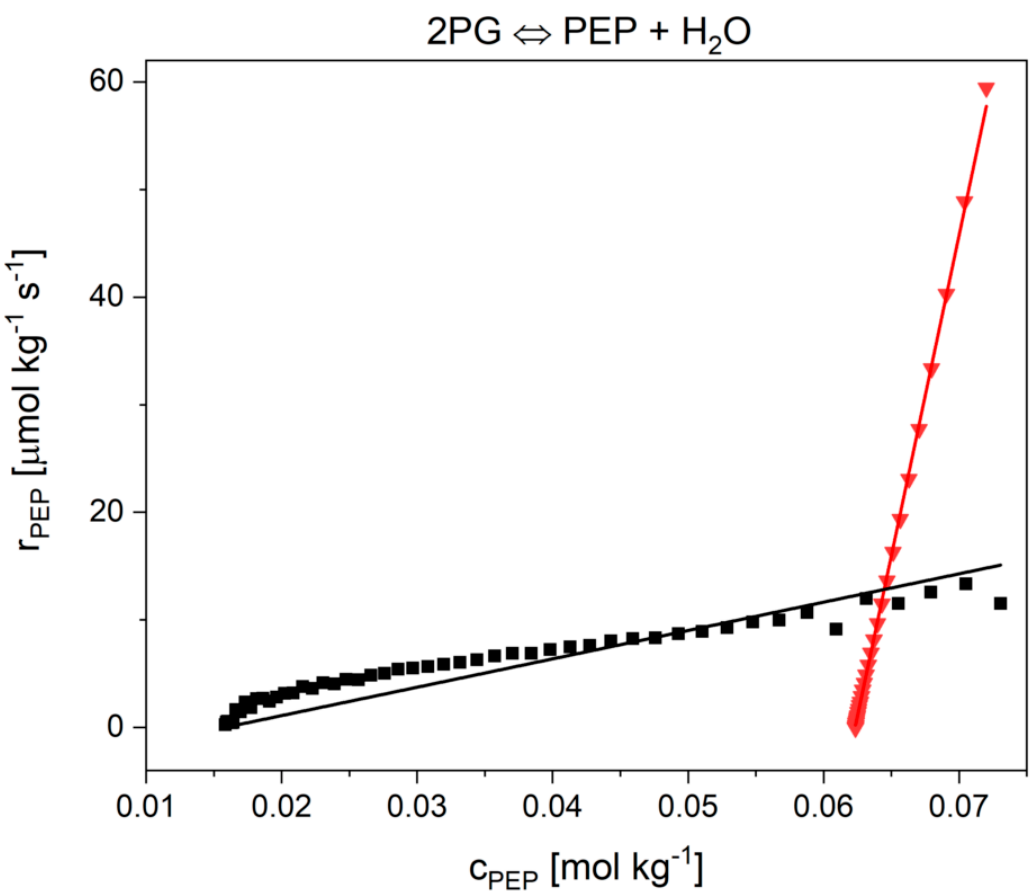
Figure 4. Fitting of the kinetic data (scatter) with the Noor model (solid lines). The adjustable parameters were Λ and K 2PG . Reaction in the presence of high crowding agent concentrations of 250 g kg − 1 PEG 20.000 (black squares) and 15 mmol kg − 1 MgCl 2 (red triangles). The fitting parameters for 250 g kg − 1 PEG 20.000 are Λ = 0.11 ± 0.01 ms − 1 and K 2PG = (1.56 ± 2.2) × 10 24 mmol kg − 1 and for 15 mmol kg − 1 MgCl 2 Λ = 1.10 ± 0.10 ms − 1 and K 2PG = ( − 4.91 ± 5.69) × 10 16 mmol kg − 1